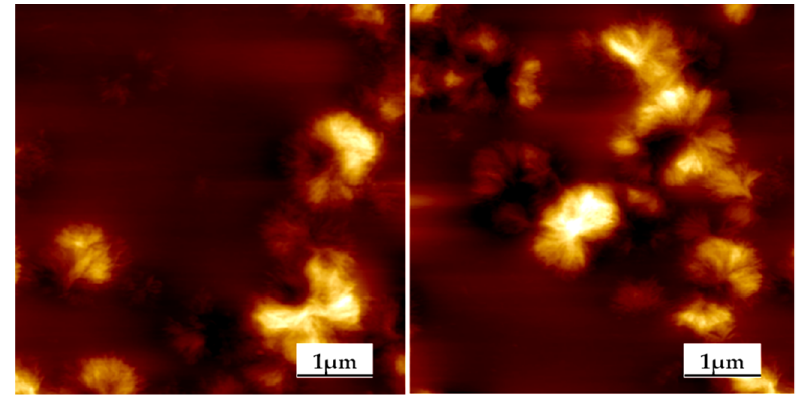
Figure 11. Spherical crystal structure of PEU8 and PEU10 hard sections.